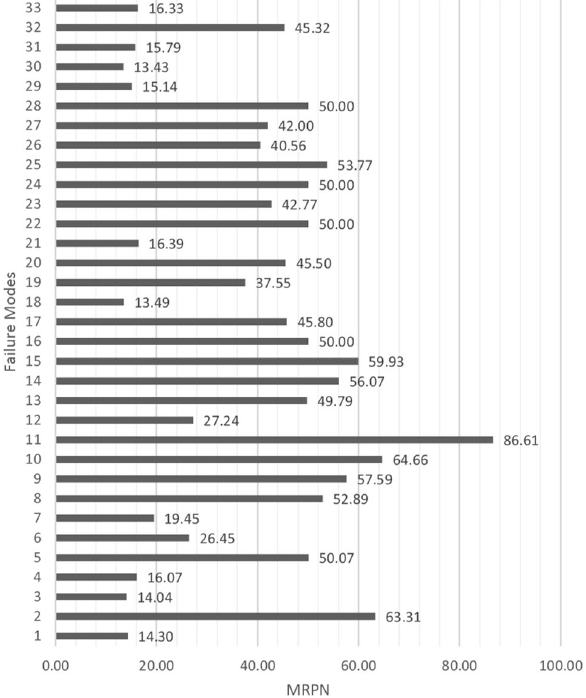
Fig. 7 Comparative chart of "MRPN"